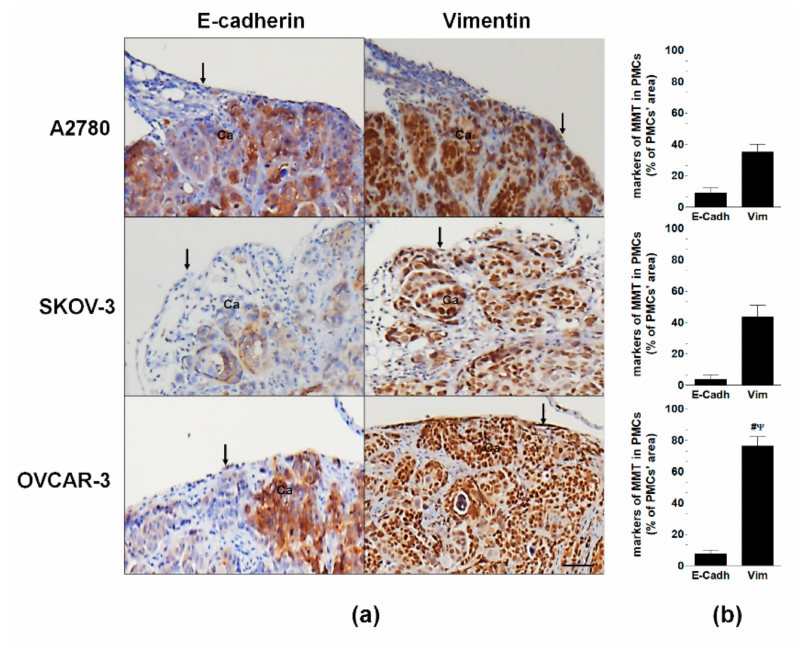
Figure 3. Features of MMT in murine PMCs in vivo. ( a ) Expression of E-cadherin and vimentin in xenografts that developed intraperitoneally following the injection of A2780, SKOV-3, or OVCAR-3 cells. Arrows indicate a layer of PMCs with different magnitudes of positive (brown) staining. Ca—cancer cells; Scale bars = 100 µm. ( b ) Quantification of the E-cadherin and vimentin levels in the biopsies using ImageJ software. Experiments were performed with tumors obtained from six animals per group. The results are expressed as the mean ± SEM. # , p < 0.05 vs. A2780; Ψ , p < 0.05 vs. SKOV-3.